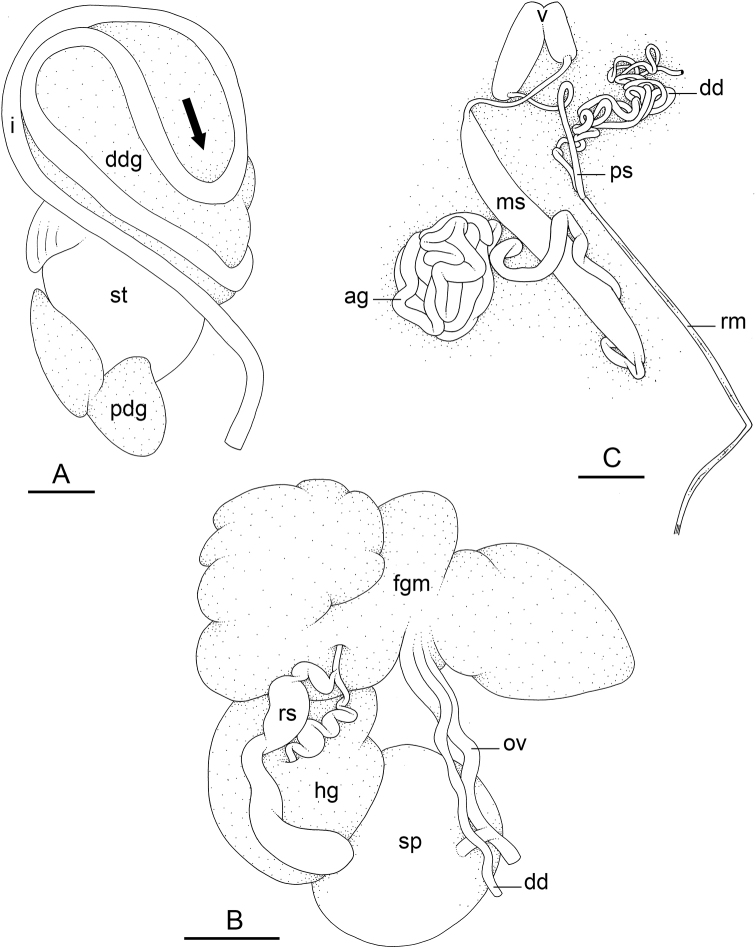
Peronia
willani, Australia, Northern Territory, holotype [1628 H] (NTM P.57625) A digestive system, dorsal view, the arrow indicates the orientation of the transitional loop B posterior, hermaphroditic (female) reproductive system C anterior, male, copulatory apparatus. Scale bars: 5 mm (A, C), 4 mm (B). Abbreviations: ag accessory penial gland, dd deferent duct, ddg dorsal digestive gland, fgm female gland mass, hg hermaphroditic gland, i intestine, ms muscular sac, ov oviduct, pdg posterior digestive gland, ps penial sheath, rm retractor muscle, rs receptaculum seminis, sp spermatheca, st stomach, v vestibule.